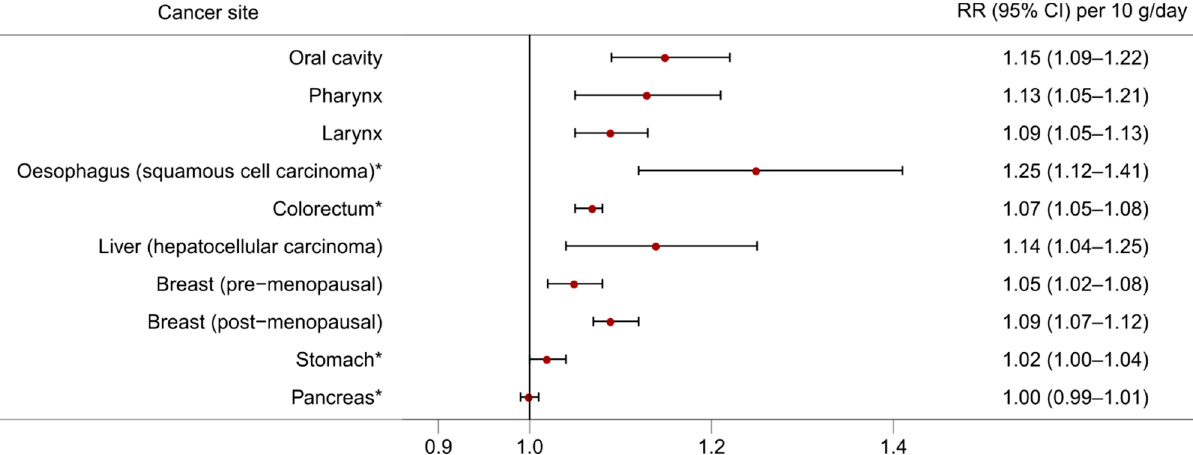
Figure 2. The dose-response relationship for the risk of cancer at different sites per 10 g/day increase in alcohol consumption. Source of relative risk estimates: WCRF Continuous Update Project [7]. RR = Relative risk; CI = Confidence interval. * Non-linear dose-response observed indicating threshold effect.